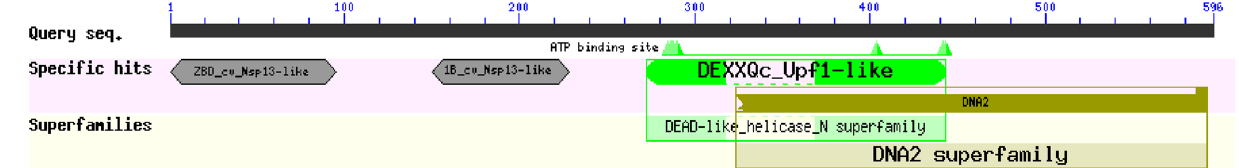
Figure 1. Protein and domain classification. Conserved domains in the SARS-CoV-2 structure were mapped using the NCBI Conserved Domain Search (CDD) tool v3.19. The SARS-CoV-2 helicase was found to be a DNA2 superfamily helicase with two significant domains: DEAD-like helicase C (spanning amino acids 323–592) and DEXXQc_Upf1-like (spanning amino acids 272–443), containing Walker A motif (GTGKSH) at N-terminus that is involved in ATP binding. Two additional functional domains ZBD_cv_Nsp13-like (spanning amino acids 1–95) and 1B_cv_Nsp13-like (spanning amino acids 150–228) were also found in the sequence. ( note: the figure is an original image generated by CDD v3.19 tool